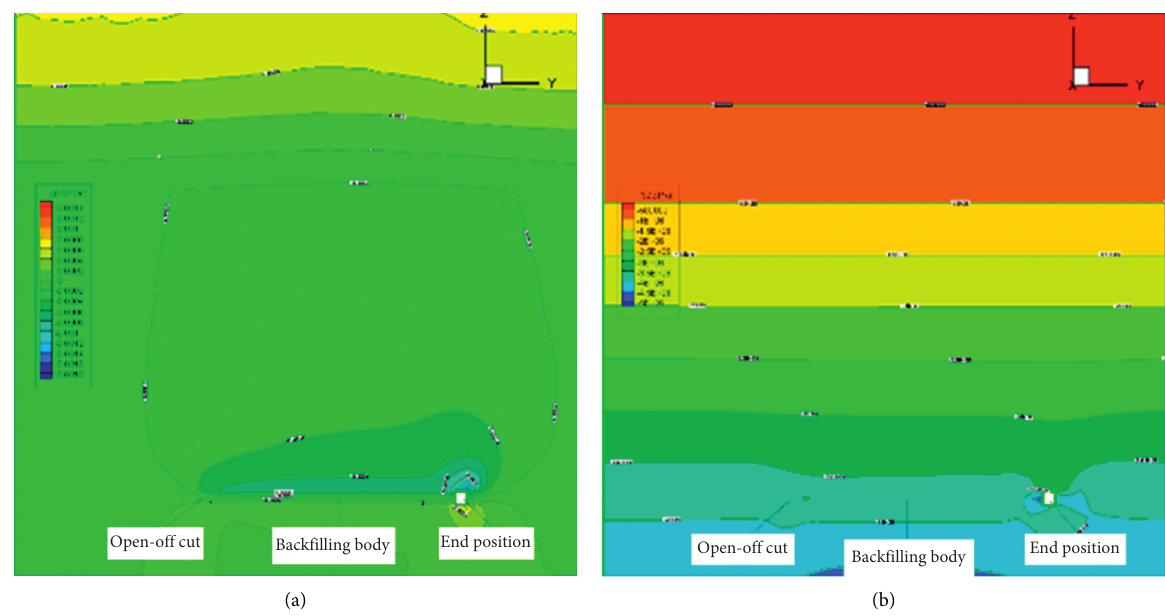
Figure 14: Movement of overlying strata when the working face advances for 100m under the elastic modulus of gangue of 20GPa. (a) Displacement vector of surrounding rock. (b) Distribution of vertical